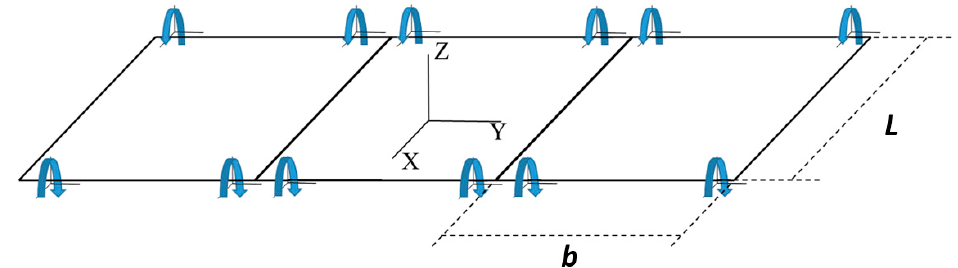
Figure 4. Schematic transverse-direction force applied. The blue lines show the torque applied on each mirror of length L and width b to obtain the necessary curvature.